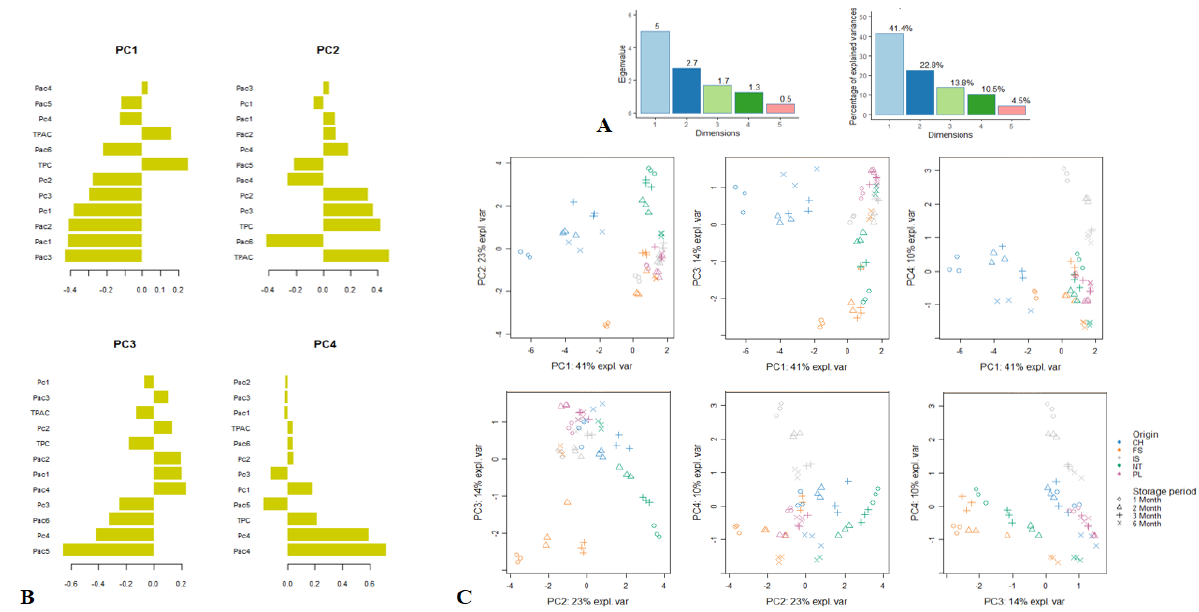
Figure 1. Principal component analysis (PCA) showing the variability of the phytochemical composition of comfrey roots depending on storage period and geographical region. ( A ). Eigenvalues and percentage of explained variance of each principal component (PC). ( B ). Loading plots displaying the relationship between the phytochemicals and the four signif- icant PCs. ( C ). Score plots showing the distribution of the samples in the six two-dimensional plans obtained from the four significant PCs; Pac1, intermedine; Pac2, lycopsamine; Pac3, acetylintermedine/acetyllycopsamine; Pac4, intermedine- N - oxide; Pac5, lycopsamine- N -oxide; Pac6, acetylintermedine- N -oxide/acetyllycopsamine- N -oxide Pc1, rosmarinic acid; Pc2, globoidnan A; Pc3, globoidnan B; Pc4, rabdosiin; TPAC, total phenolic acid content; TPC, total phenolic content.